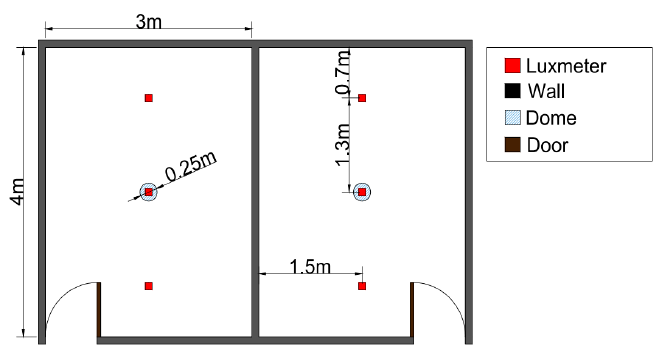
Figure 3. Representational layout of the elements that make up the test environment.